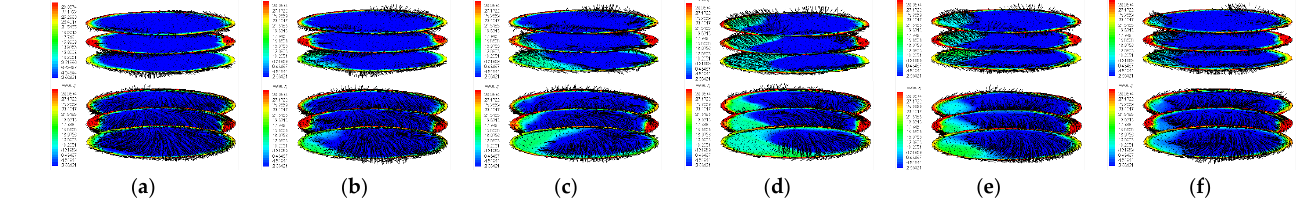
Figure 20. When inlet pressure = 15 MPa, gap = 1.5 mm, the variation of velocity of the original suction cup with time in adhesion interface plane at: ( a ) 5 ms, ( b ) 9.4 ms, ( c ) 13.8 ms, ( d ) 18.2 ms, ( e ) 22.6 ms, and ( f ) 27 ms.